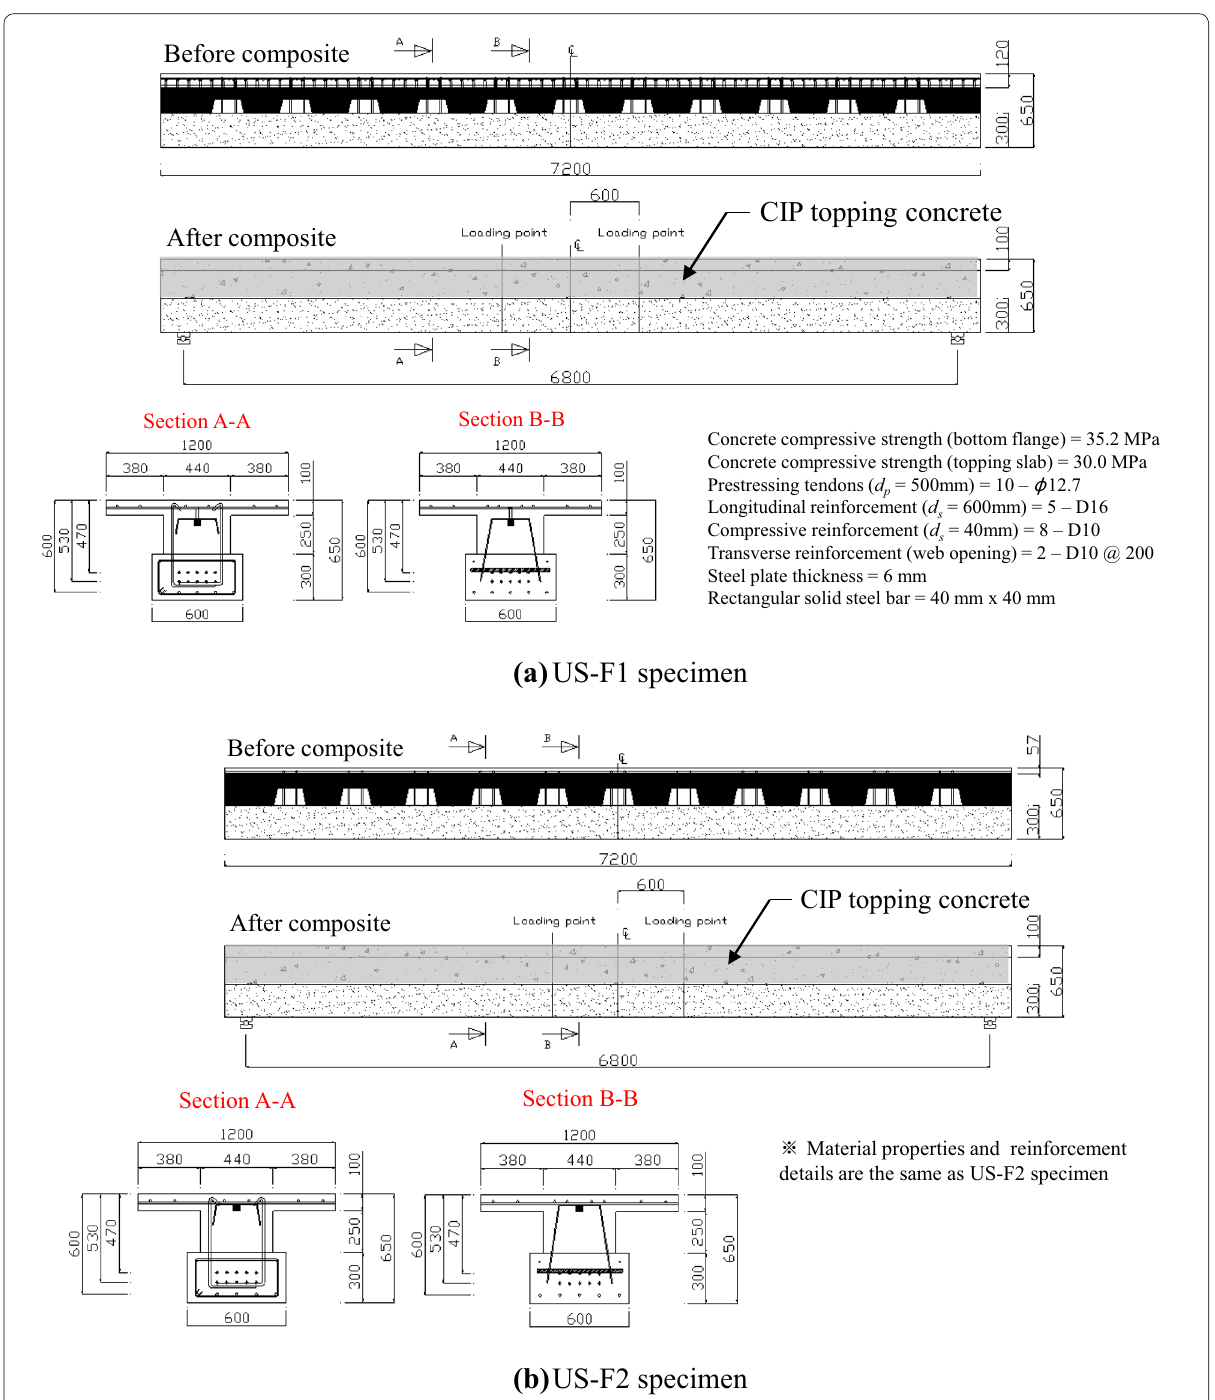
Fig. 3 Dimensional details of test specimens (unit: